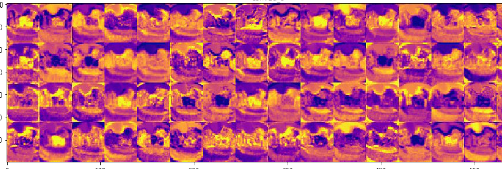
Figure 9(a). Saliency map for convolution layer